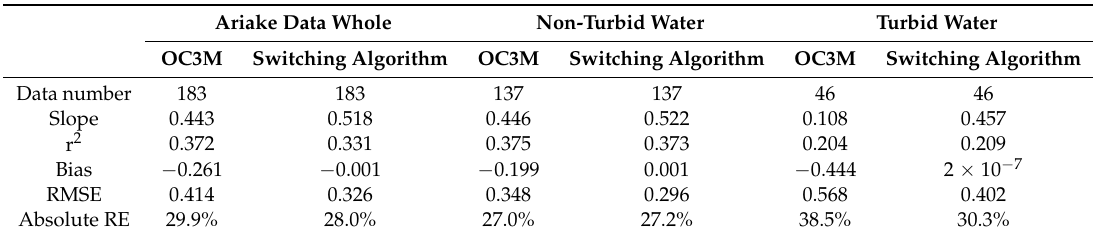
Table 3. Statistics of OC3M and the new switching algorithm.